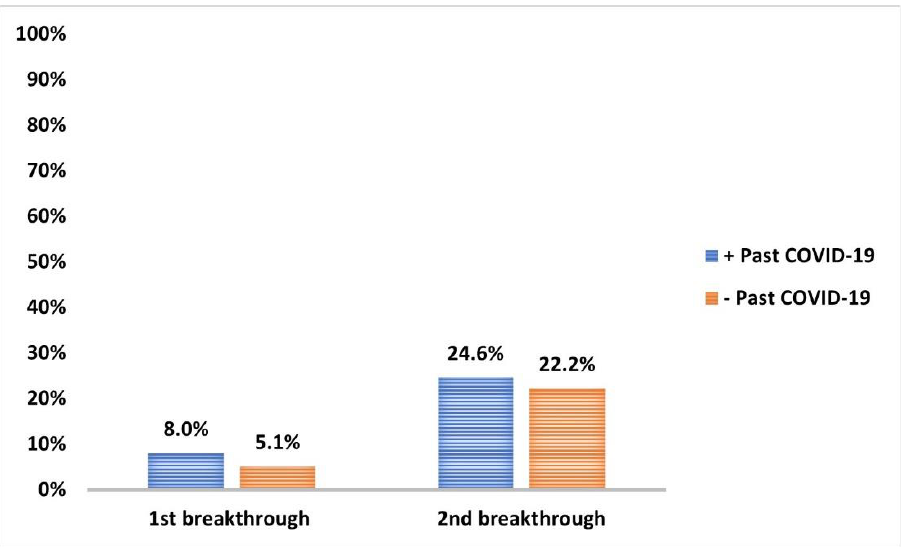
Figure 8. Frequency of 1st breakthrough and 2nd breakthrough COVID-19 infections in those who experienced past COVID-19 and those who did not. Data were analyzed by chi-square test and p = 0.6.